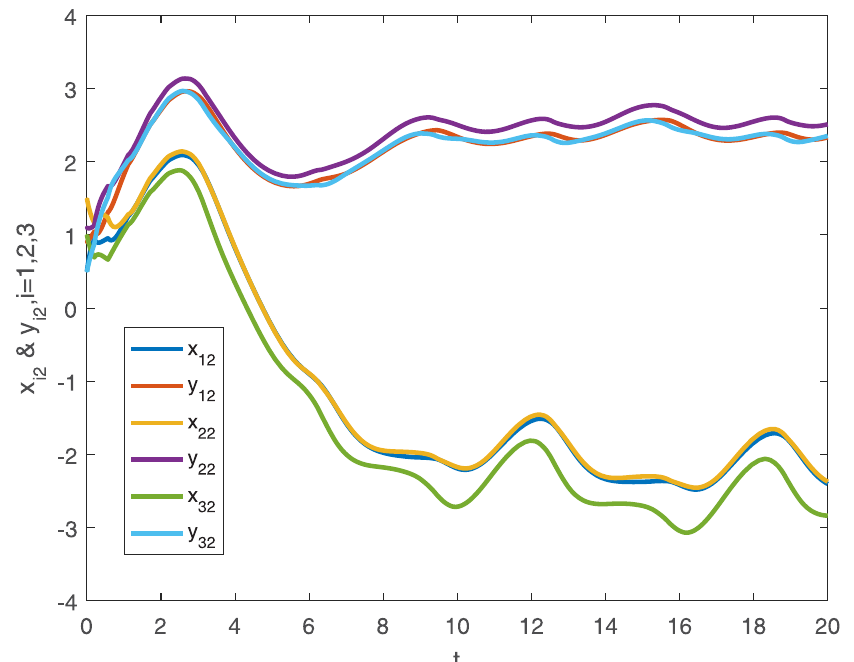
Fig 2. The second dimensional trajectories of the drive system (18) with initial conditions x 1 ( t 0 ) = [0.5 + sin ( t ), cos ( t ) − 0.5] T , x 2 ( t 0 ) = [ sin ( t ) − 0.5, 0.5 + cos ( t )] T , x 3 ( t 0 ) = [ sin ( t ), cos ( t )] T and response system (19) with initial conditions y 1 ( t 0 ) = [0.1 + sin ( t ), cos ( t ) − 0.1] T , y 2 ( t 0 ) = [ sin ( t ) − 0.1, 0.1 + cos ( t )] T , y 3 ( t 0 ) = [0.5 + sin ( t ), cos ( t ) − 0.5] T when no controller (8).